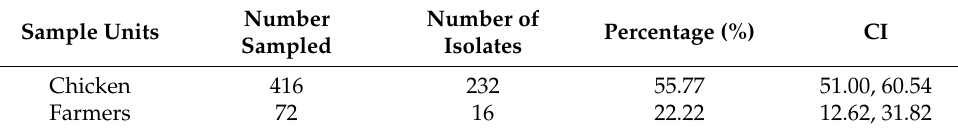
Table 1. Global distribution of SE according to the participant